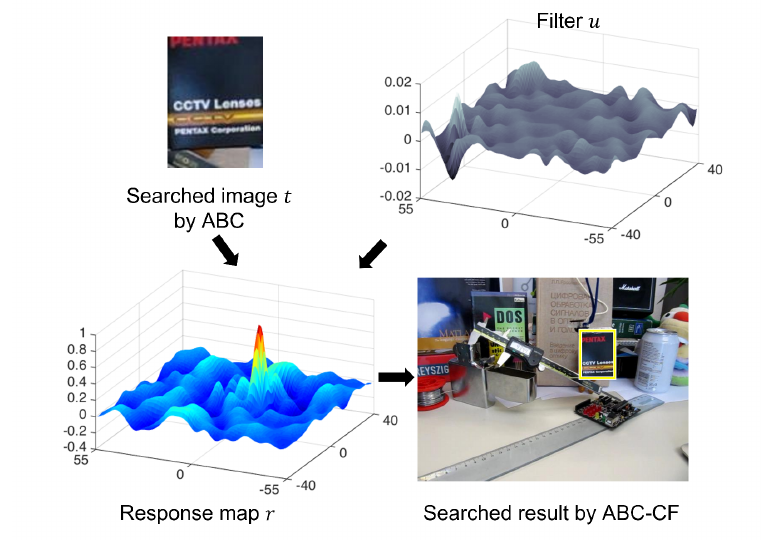
Figure 9. Overview of ABC-CF